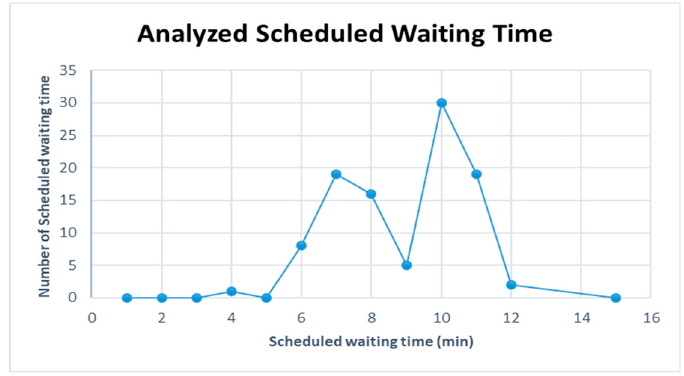
Figure 7. Analyzed Scheduled Waiting Time for Case 1.